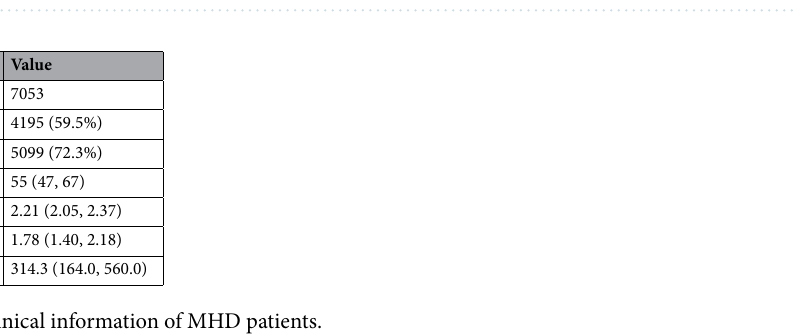
Figure 4. Distribution of utilization rates of different medications used to reduce P levels in the included centers.